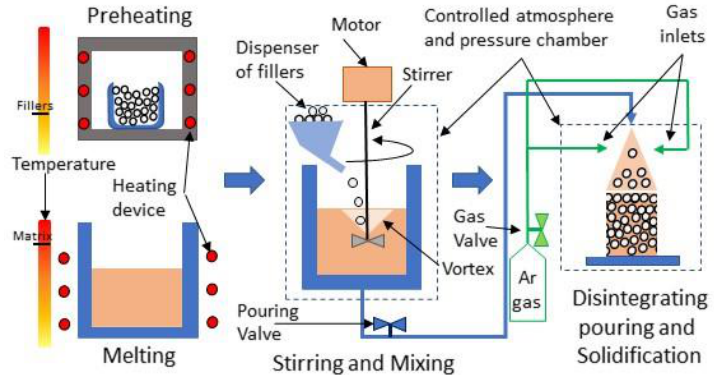
Figure 5. Disintegrated melt deposition process scheme for MMSFs. Table 5. Range of values of parameters governing the disintegrated melt deposition (DMD) process.